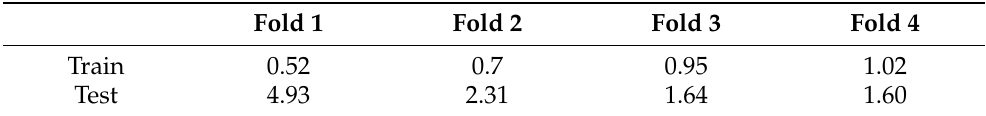
Table 7. Average RMSE moving origin four-fold cross validation results in the training and test sets for the GRU (250 Cells) + Dense model.